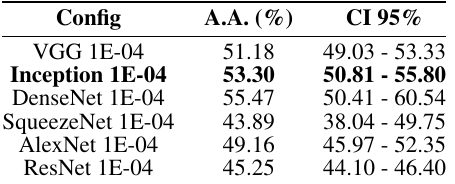
the Construction Method Task.